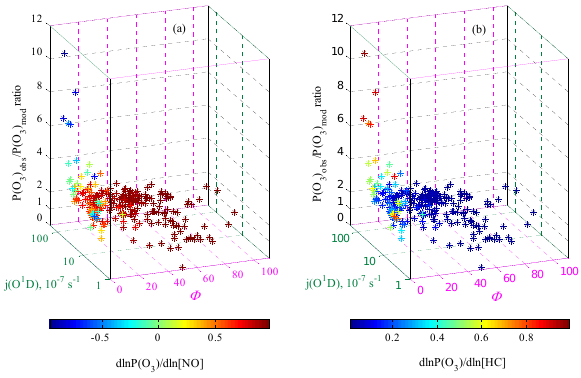
Fig. 11. Dependence of the ratio of observed P (O 3 ) to modeled P (O 3 ) (P(O 3 ) obs /P(O 3 ) mod ) on (a) dln P (O 3 )/dln[NO] and (b) dln P (O 3 )/dln[HC] at different j (O 1 D) and Φ values for daytime 10-min average data during 18-21 September, 2003. The color of the asterisks shows (a) dln P (O 3 )/dln[NO] and (b) dln P (O 3 )/dln[HC] at the corresponding time.